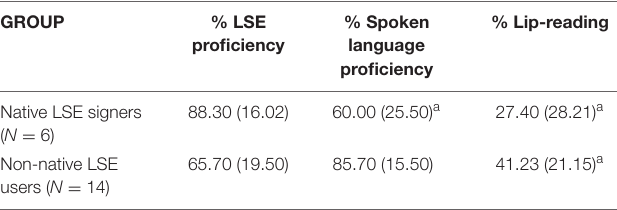
TABLE 3 | Total scores on linguistic skills across native profoundly and severely deaf native LSE signers and non-native long-term LSE users. GROUP % LSE